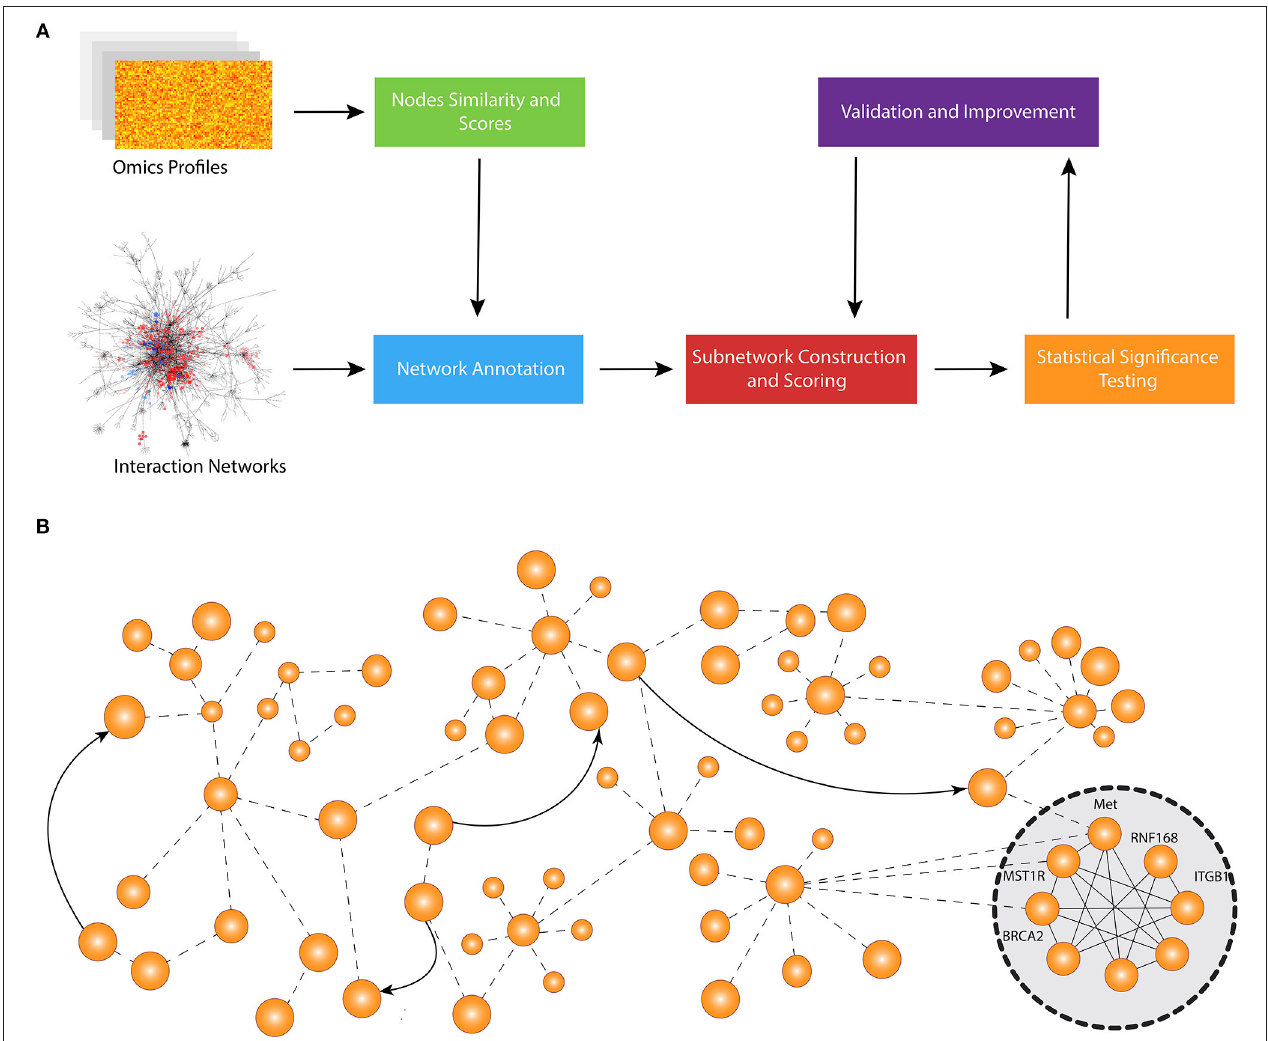
FIGURE 1 | Overall workflow of active subnetwork identification. (A) Schematic representation of computational approaches that integrate molecular profiles with known interactions accumulated in knowledge bases. Most methods start by scoring the nodes and calculating node similarity that reflects the expression change (e.g., between disease and control) and correlation between genes, respectively. Then, they adjust the scores and edge weights by taking into consideration the topological order and interaction between genes and proteins. The next step is to construct the subnetworks using edge weights and node scores. Typically, each method develops a specific subnetwork extension strategy in order to optimize a specific subnetwork scoring function using node scores and edge weights. After the subnetworks are constructed, each method performs a hypothesis testing to assess the statistical significance of identified modules. Some methods also repeatedly reconstruct the subnetwork after statistical tests to find a more optimal solution. (B) An example network and identified active subnetwork. The subnetwork are often a very well-connected component of the global network.